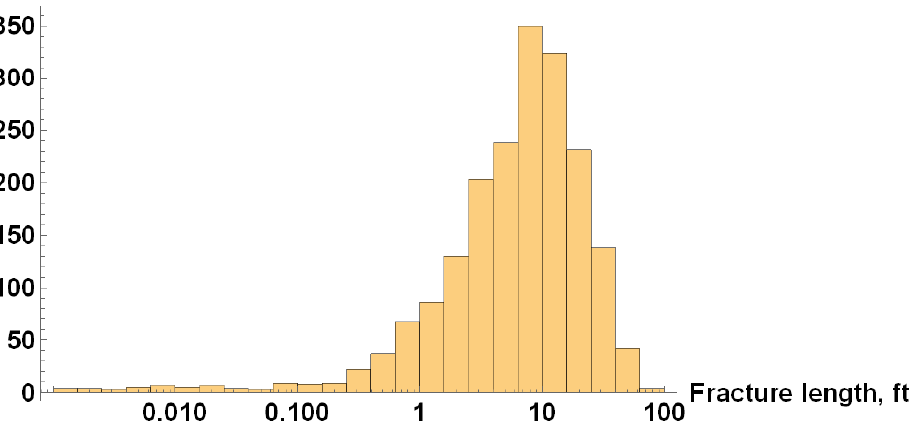
Figure 10—Histogram of the fracture length in Case